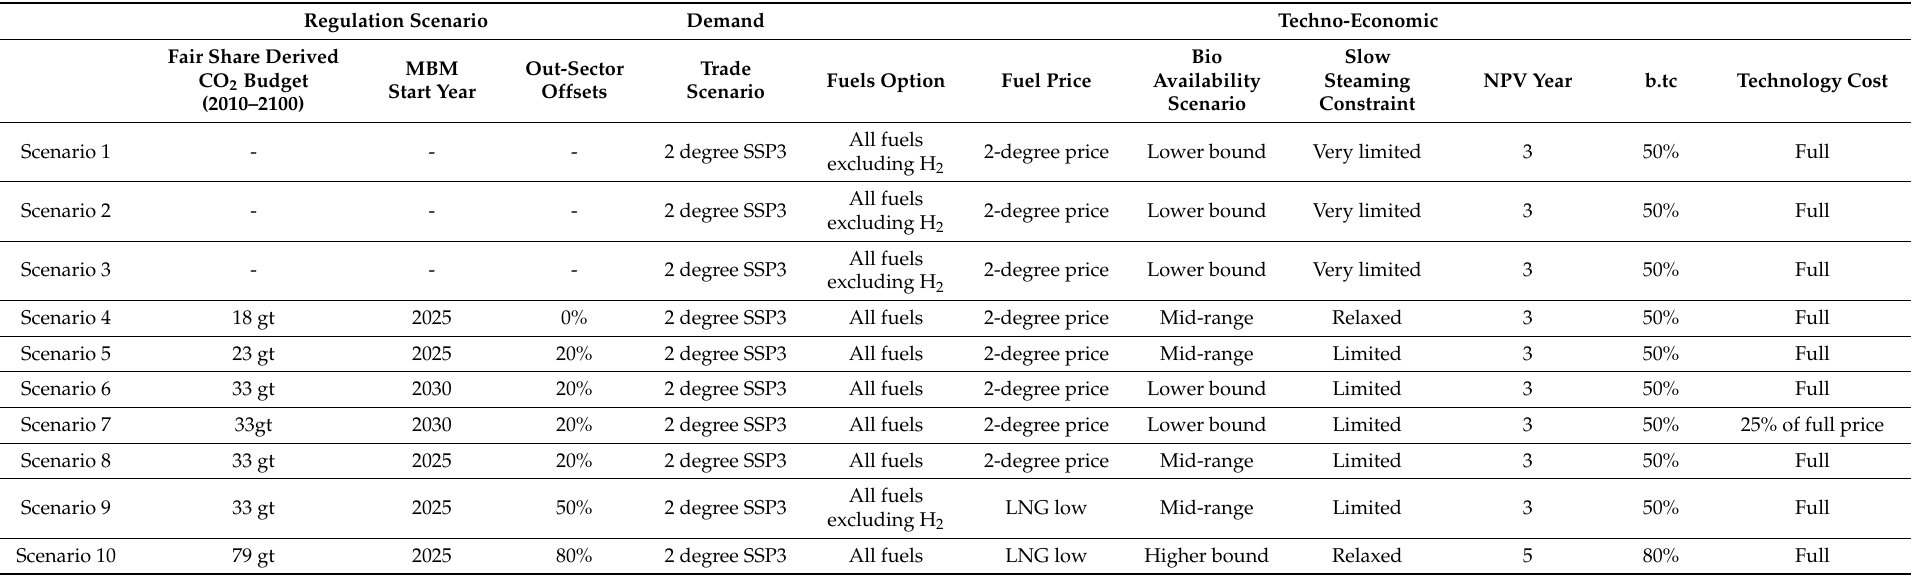
Table 1. Scenarios tested for determining emergent fuel